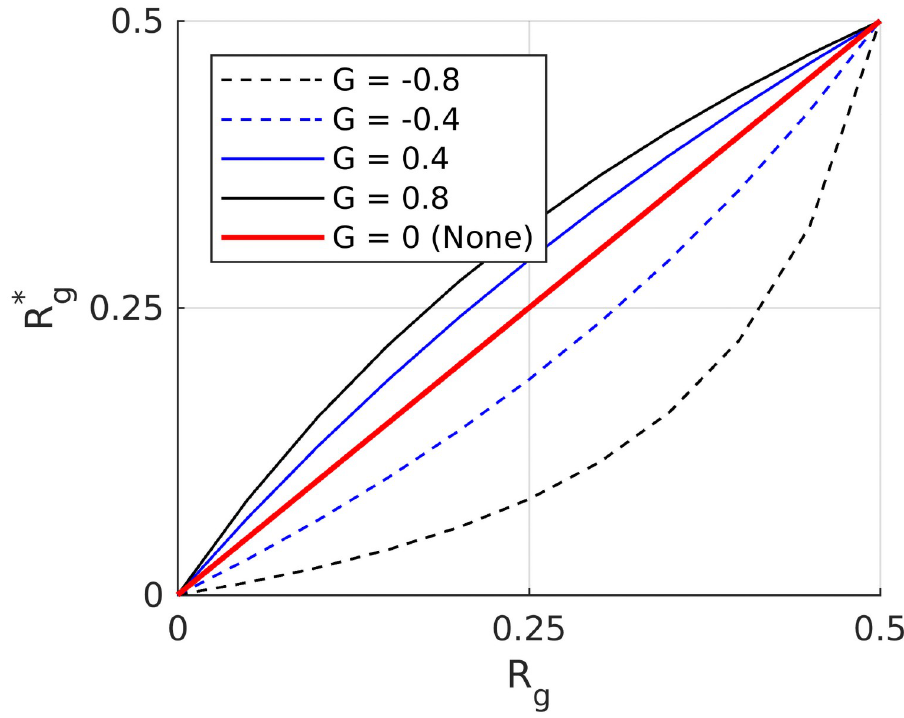
Fig 5. Filter responses before and after applying Eq 4. Each curve represents a different scalar value for the gain control G (notice that in Eq 4, G is two-dimensional). The values of G corresponding to each curve are indicated in the figure